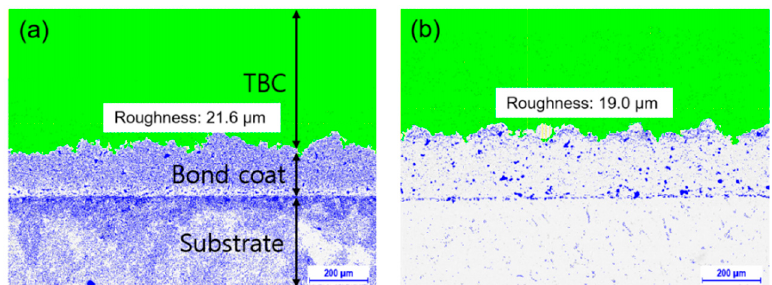
Figure 5. Post-processed optical microscope images of the bond coat surface representing a significant increase in the surface roughness compared to the fresh state (Figure 3b): ( a ) First-stage blade (sample 1 in Table 1) and ( b ) second-stage blade (sample 4 in Table 1).